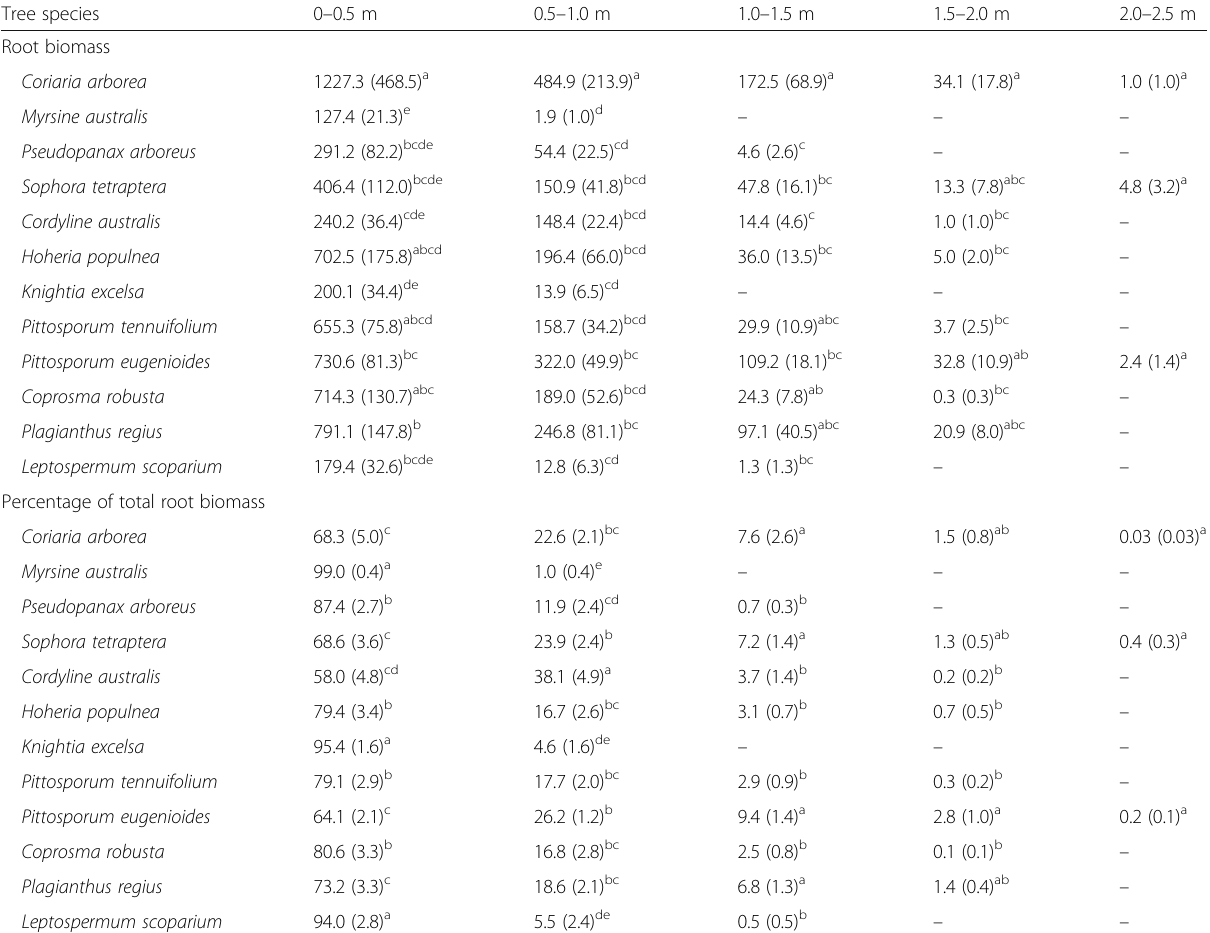
Table 3 Mean total root biomass (g) and percentage of total root biomass by 0.5 m radial increment from the root bole by year 5 Tree